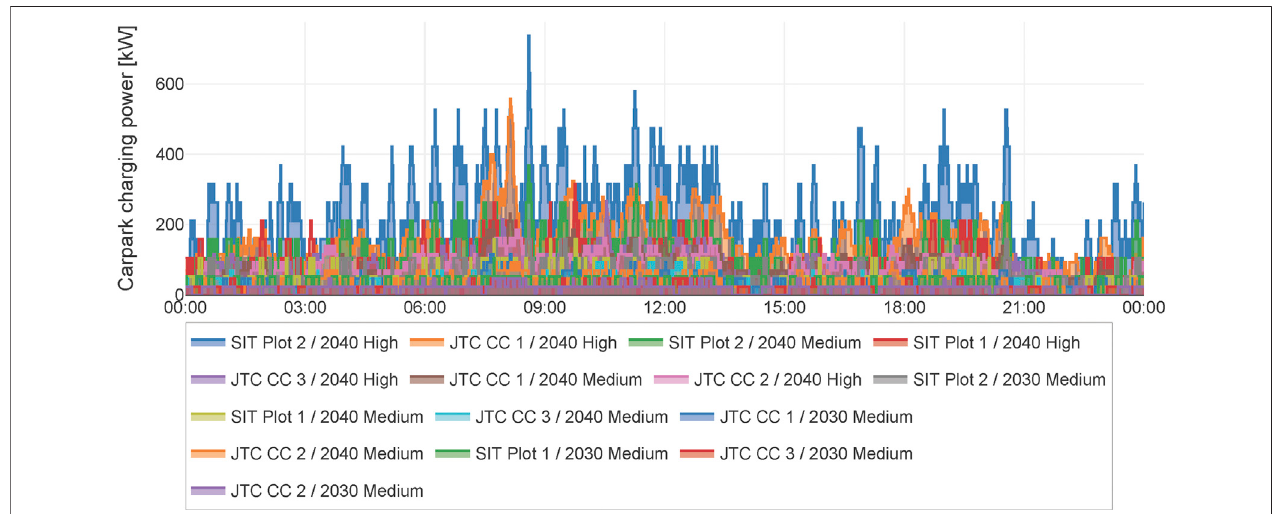
FIGURE 6 | PDD car park charging power time